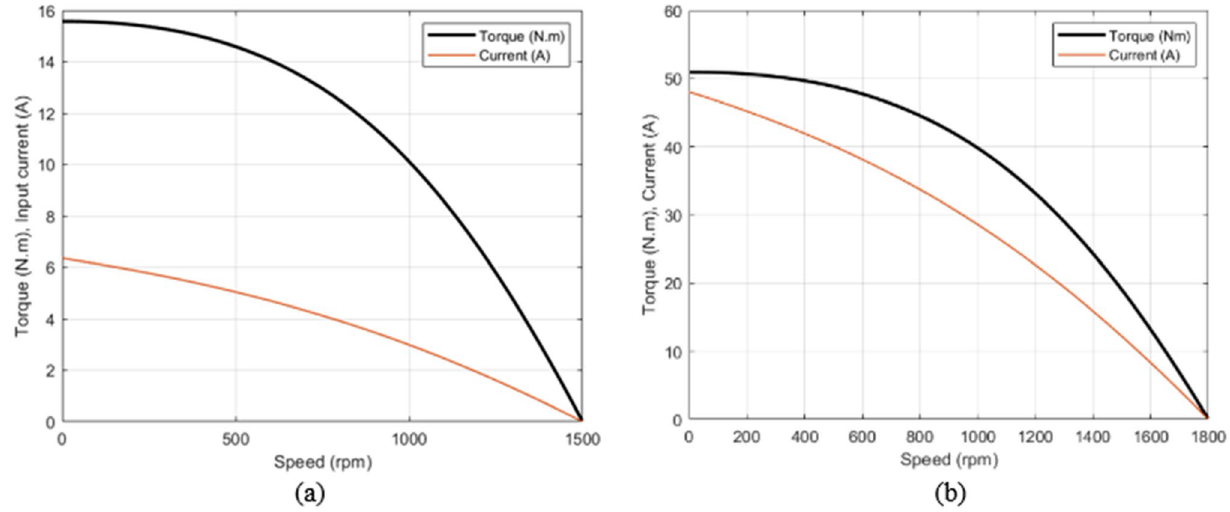
Fig. 9 Torque-speed characteristics for Motors M1 and M2 at calculated values of R ′ 2 . for maximum starting